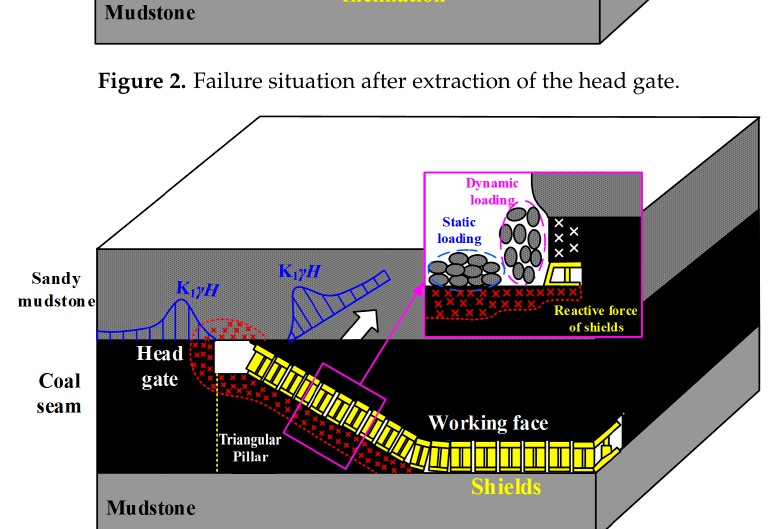
Figure 3. Failure situation while the working face is advancing.